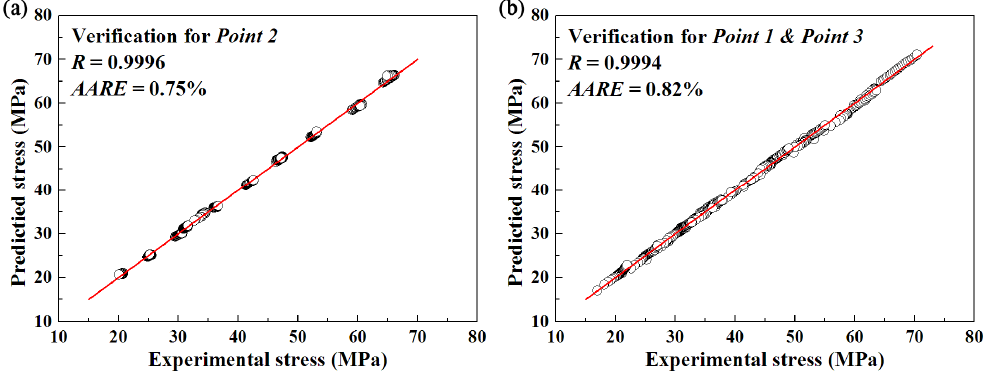
Figure 10. Accuracy evaluation of the established FB model: ( a ) verification for Point 2; ( b ) verification for Point 1 and Point 3.